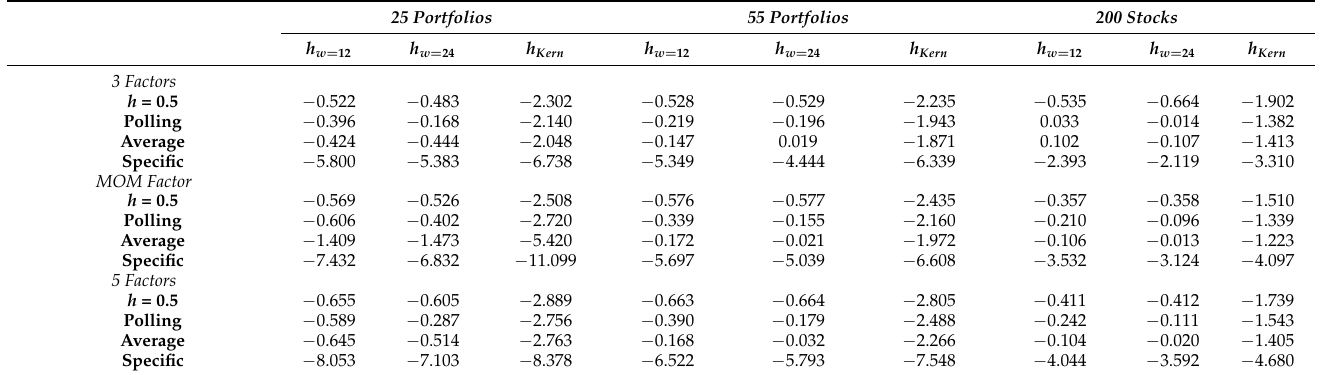
Table A5. Percentage reduction in RMSEs for different asset pricing